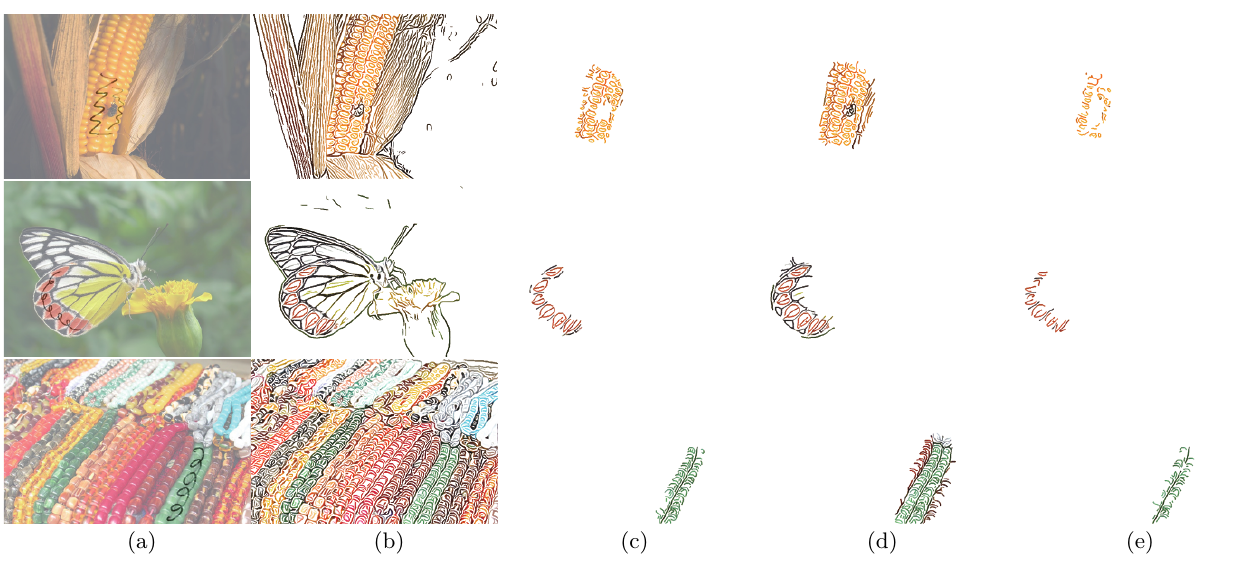
Fig. 11 Comparison with naive methods. (a) Input image and user strokes. (b) Detailed color line drawings by fDoG [2]. (c)–(e) Lines extracted by (c) our system with costs less than one standard deviation, (d) naive near neighbor search (NN), and (e) naive line-stroke intersection test